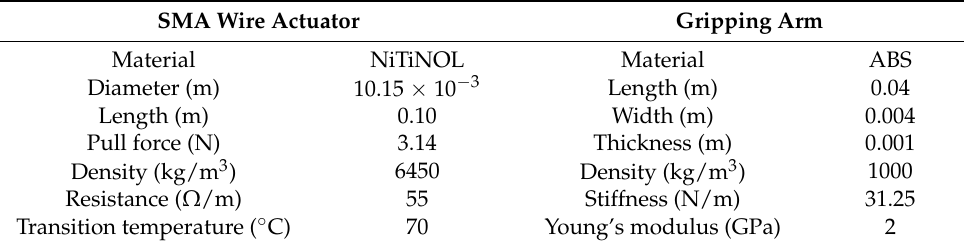
Table 1. Dimensions and specifications of the constituents of the monolithic compliant gripper.